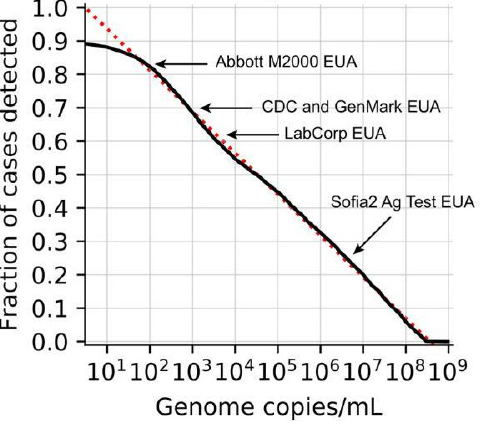
Figure 2. Fraction of SARS-CoV-2 detected are plotted against the LoD. Reprinted with permission from [41]. Copyright 2020, Arnaout et al., under Creative Commons Attribution 4.0 License.